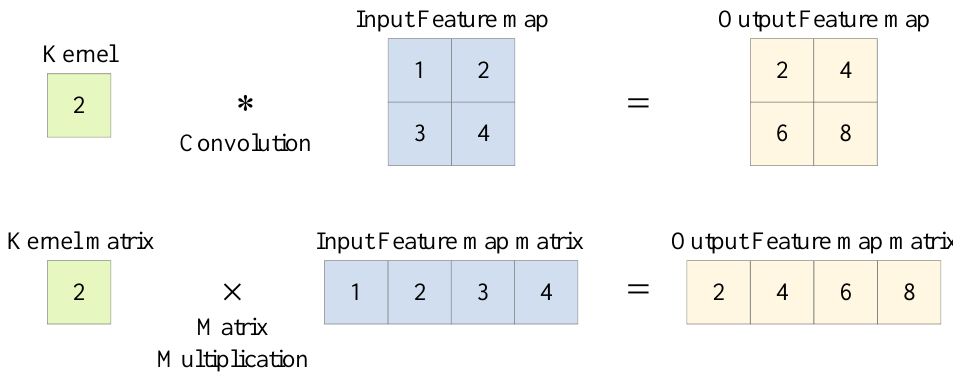
Figure 12. Two-dimensional convolution with kernel size 1 × 1. Figure 13 illustrates the convolution module based on the Im2col+GEMM algorithm. DMA transfers a feature map with a size of Tx × tr × tc and corresponding weight pa- rameters with a size of Tx × Ty to the on-chip memory each time. The input feature map is stretched into Tx vectors with length tr × tc by the Im2col function in the direction indicated by the arrow. Then, we send Tx × Ty weights and the feature map vector into a parallel multiplier for the dot product operation. After this, Tx × Ty intermediate results with a length of tr × tc are divided into Ty groups according to the output dimension and sent to the parallel adder. The additional result of each group is the result of a certain layer of the output feature graph. After all groups are operated by the adder, the final result is converted into the matrix form of Ty × tr × tc as the output.